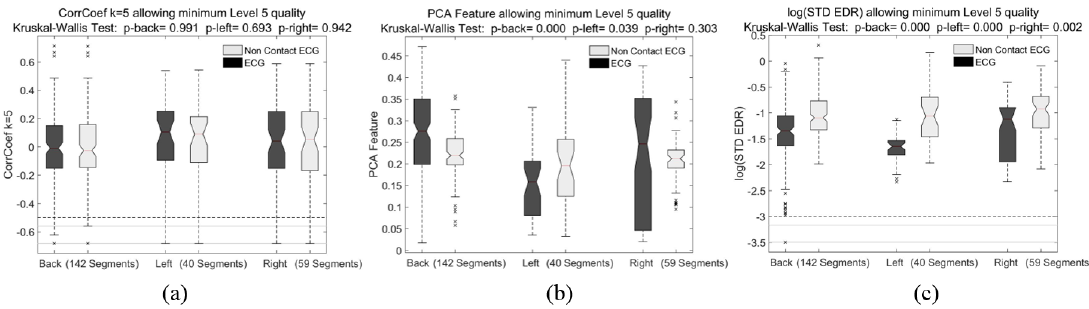
Figure 8. Results of extracting serial correlation coefficient of R-R intervals CorrCoeff ( a ); a PCA-based feature ( b ); and the SD of the EDR ( c ) from all the 30-second segments in the best channels per measurement. The extracted features from ccECG and reference ECG are presented, together with Kruskal-Wallis Test p -values. The boxplots present the results of including the signal segments with a Visual Quality of Level 5 and 6. Kruskal-Wallis Test results show that the CorrCoef feature is not significantly different between ccECG and ECG, but that the PCA-based feature and the SD of the EDR are significantly different between the two methods. The remaining features regarding the relative power and relative residual power of the HR component (not shown) were also significantly different when extracted from ccECG and ECG, since they include the PCA feature and EDR.